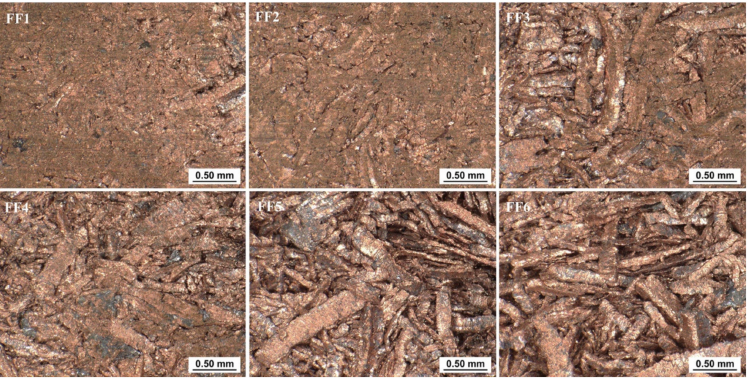
Figure 22. Pictures of the selected areas of the front surface of the